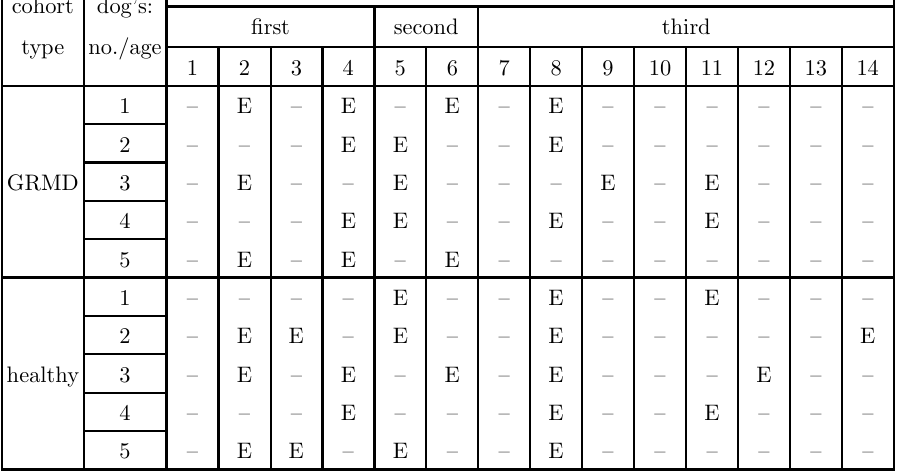
Table 1. The examination moments (marked with ‘E’), with respect to the dog’s age given in months. Each examination is assigned to one of the three phases of canine growth and/or dystrophy development. Each row of the table corresponds to a different dog phase of canine growth and/or dystrophy development cohort